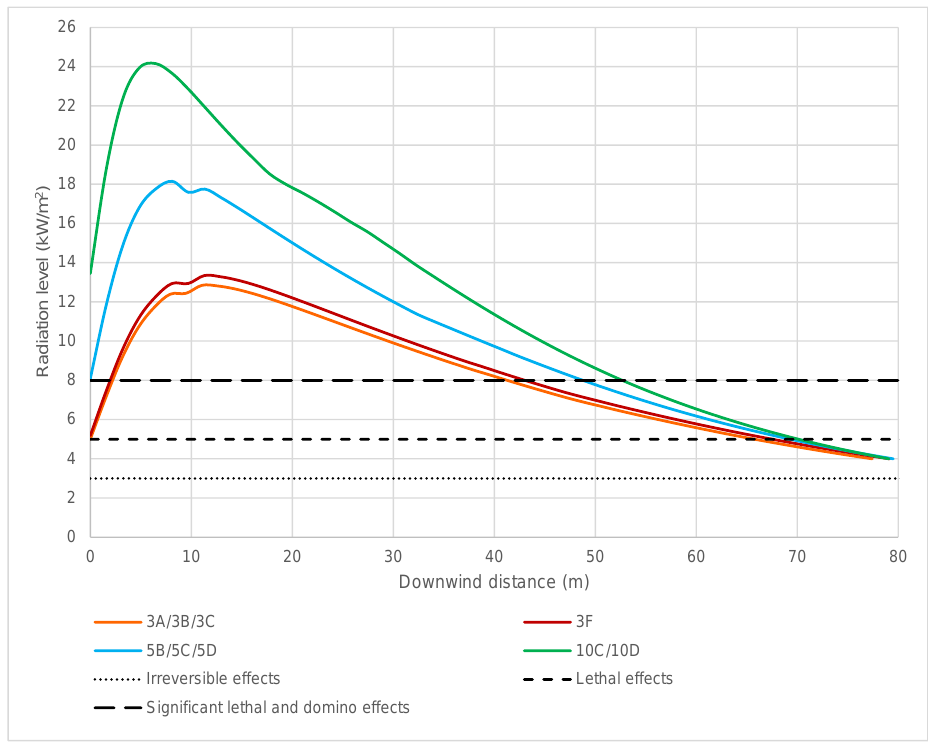
Figure 7. Radiation levels generated at 1.5 m by a jet fire in the EZ53 salt cavern.